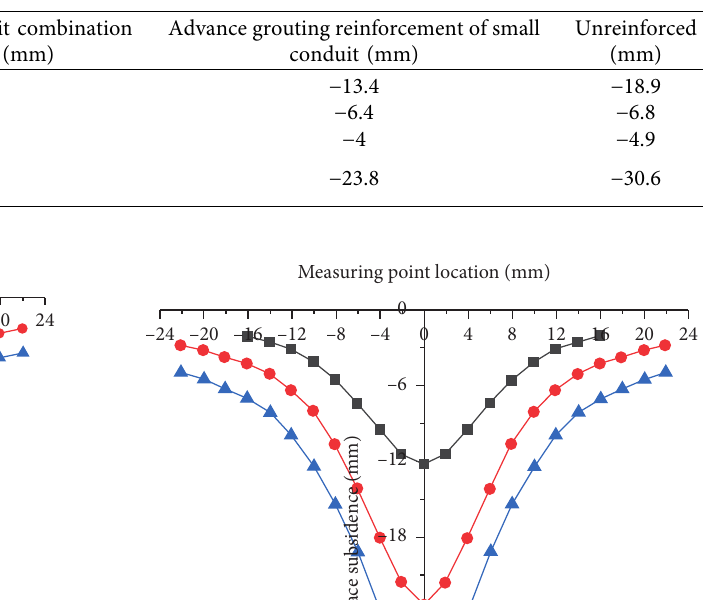
Table 3: Comparison of surface settlement values caused by each process.